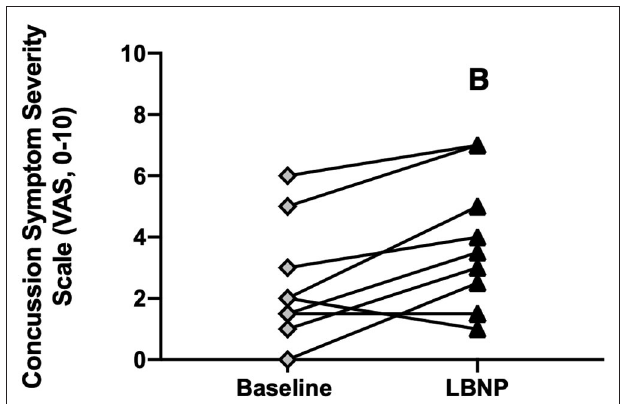
FIGURE 5 | Concussion symptom severity rating (Visual Analog Scale, 0–10) at baseline and after LBNP for concussed athletes ( n = 10). Values are mean ± SD. B, different from baseline ( P ≤